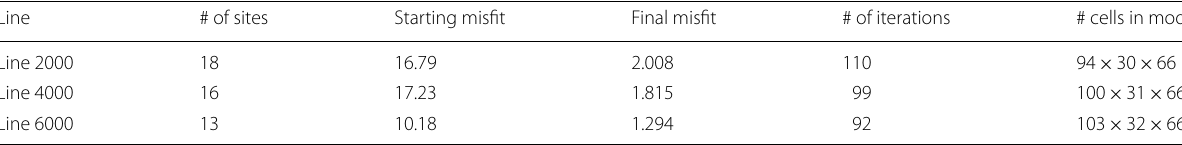
For each profile line, information is provided including the number of sites, the starting model RMS misfit, the final model RMS misfit, the total number of iterations, and the number of cells used in the model